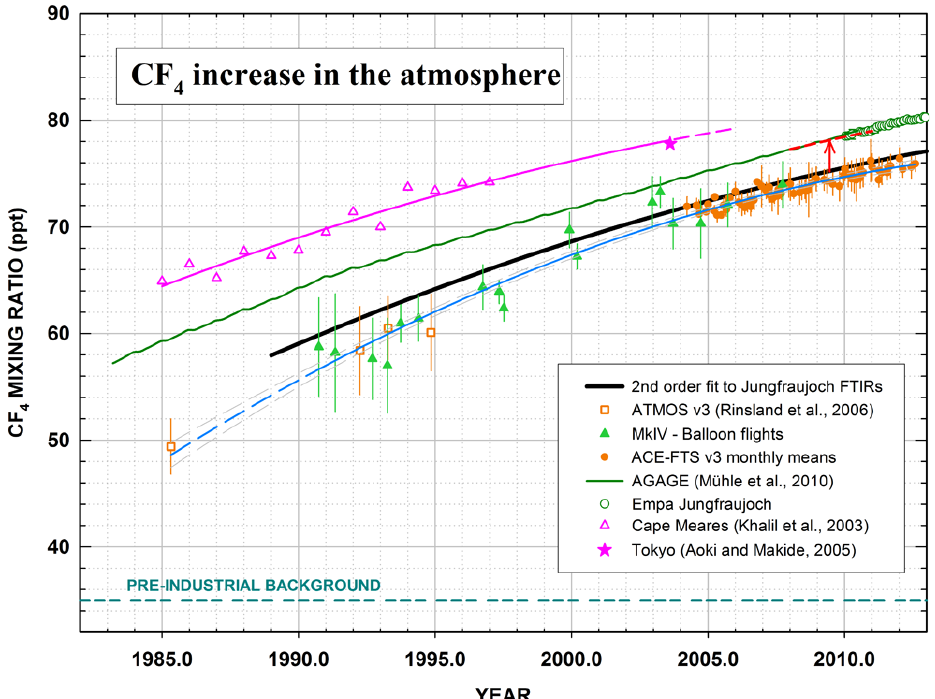
Fig. 3. Comparison between selected CF 4 mixing ratio time series and trends deduced from infrared remote-sensing and in situ surface measurements (see legend and text for their identification). The various data sets can all be reconciled in term of absolute concentration when accounting for the associated uncertainties affecting the retrieved quantities (calibration scales, line parameters) and time needed for a thorough mixing of CF 4 throughout the atmosphere. See text for